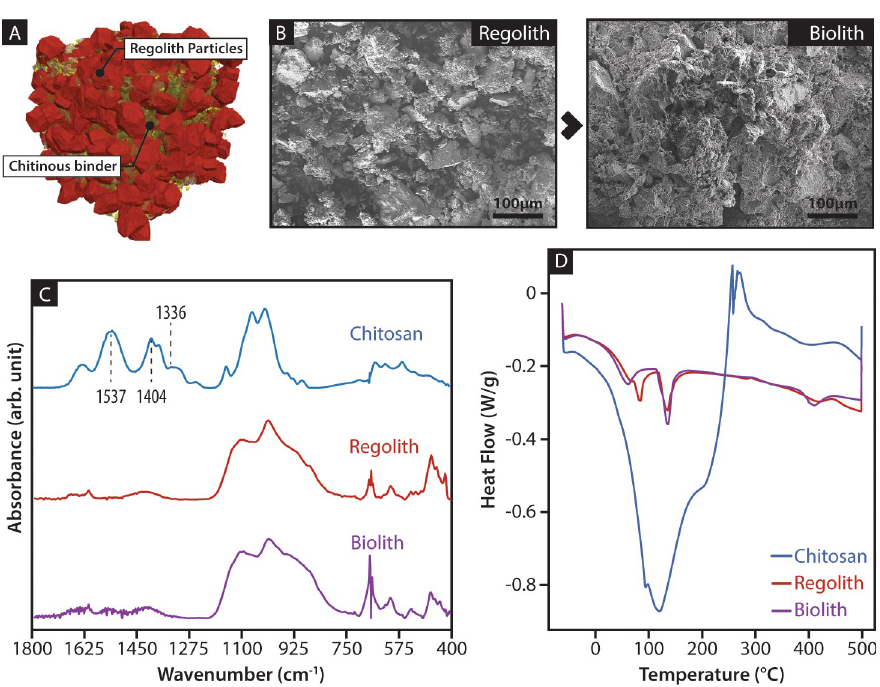
Fig 1. Micro-scale organization of biolith. (A) Regolith particles are dispersed within the chitosan solution after mixing. After the evaporation of the water, the chitosan crystalizes, reduces volume, and pulls the regolith particles together; (B) SEM imaging of regolith particle showing irregular size and morphology. Crystallized chitosan in the biolith can be seen enveloping and agglutinating the particles; (C) FTIR between chitosan, regolith, and biolith did not show conclusive evidence of a chemical reaction between chitosan and regolith; (D) Similarly, differential scanning calorimetry results did not reflect the heat flow patterns indicating phase changes between regolith and biolith. 1:125, producing agglomerations of different bulk behaviors ranging from the inability to retain shape due to an excessive dispersive phase to the inability to form cohesive structures due to an excessive inorganic phase. Same trend was also observed and quantified in the mechanical testing of the material. Molecular and thermal analyses showed a lack of chemical interaction between the inorganic phase and the chitinous polymer (Fig 1C and 1D), suggest- ing that the composite is aggregated and internally compacted by strong intermolecular forces produced by the chitinous polymer during crystallization. After the aqueous solvent evapo- rated, the range of 1:75 to 1:100 led to the crystallization of the composite into solid structures with maximum flexural strength and stiffness (Fig 2A and 2B). These binder concentrations are between one-fifth and one-half of the amount of binder previously reported for “ultra-low- binder-content” composites (e.g., polystyrene (PS) or polylactic acid (PLA)) [24, 25]. The versatility of biolith in applications without elevated temperature or pressure (Fig 2C and 2D) is demonstrated in an unprecedented range of manufacturing methods, such as cast- ing, using it as mortar and in additive manufacturing (Fig 2E and 2F). The initial products of biolith could be consumable tools and equipment mass fabricated by hand or casting. A prag- matic test for the casting potential of biolith was performed by producing a functional wrench (Fig 3A), which was tested by tightening a hexagonal bolt (Fig 3B). While biolith could not replace metallic tools, the simple wrench was able to sustain a torque of 2.83 ± 0.92 Nm before breaking, matching the torque specified for M5 bolts used in non-critical space applications (Fig 3C) [26]. This demonstrates the practical utility of a tool made with biolith and its useful- ness on Mars, as requirements would likely be different due to the lower gravity and